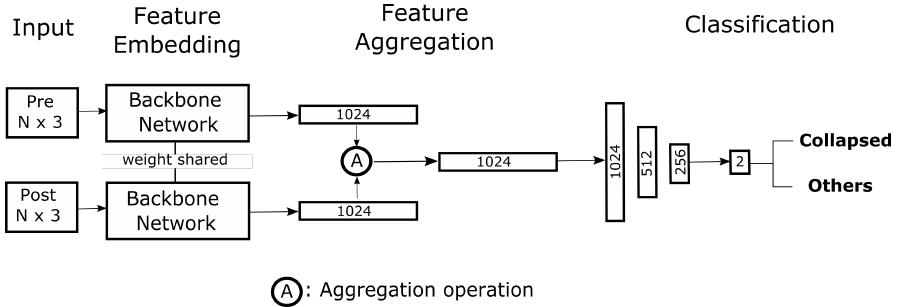
Figure 7. Proposed framework to extend a single-input network to the double-input pre–post scenario. N represents the number of points in the point clouds. Numbers indicates the dimensions of the